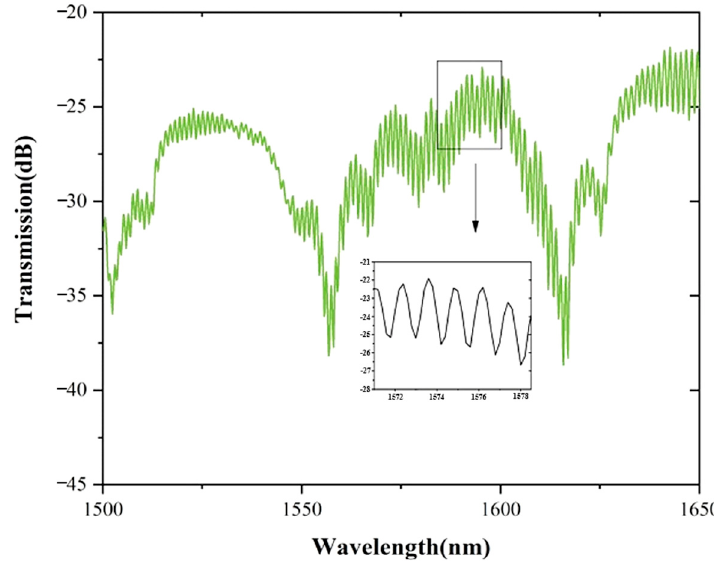
Figure 4. Experimental spectrum of the combinational two different mechanisms.